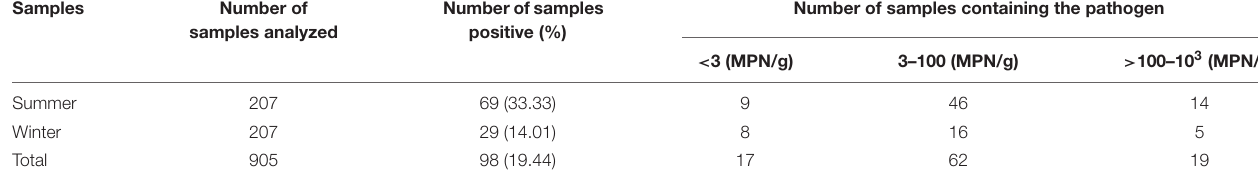
TABLE 2 | Prevalence of Vibrio parahaemolyticus during different seasons.